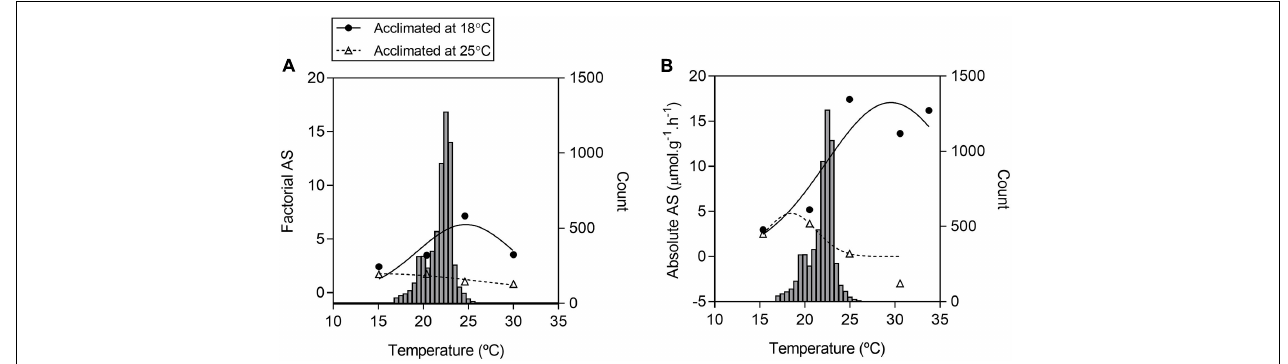
FIGURE 4 | Frequency of water temperature and aerobic scopes of tadpoles of Bokermannohyla ibitiguara over a range of test temperatures. Factorial aerobic scope [ (A) FAS] is calculated from the ratio between mean values obtained for mass-specific maximum metabolic rate ( m ˙ MO 2 ) and routine metabolic rate ( r ˙ MO 2 ). The absolute aerobic scope [ (B) AAS] is calculated from the difference between mean values for m ˙ MO 2 and mean values for r ˙ MO 2 over a range of different temperatures (15 ± 0.06 ◦ C to 30 ± 0.05 ◦ C). Histograms of the frequency of stream temperature are repeated in panels (A,B) , representing the records collected by the data logger every hour between October and May. The right axis indicates the count of records of each water temperature, and the left axis corresponds to the calculated aerobic scope.